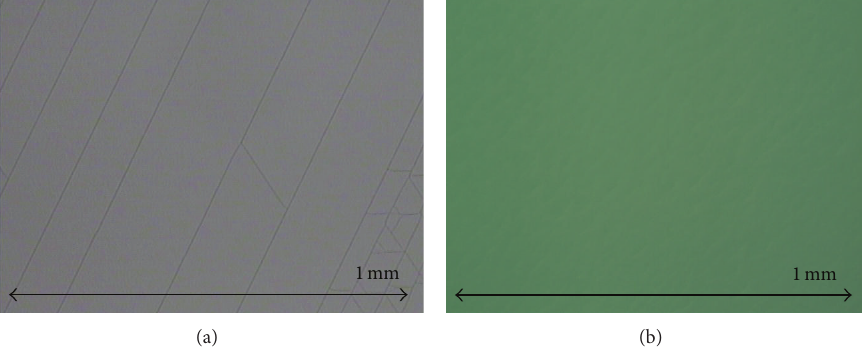
Figure 3: Optical photography of AlGaN/GaN surface grown on Si substrate with Al (a) and AlSiC precoverage interlayer (b). explains that AlSiC precoverage is effective in compensating tensile, considering the reference value of 567.5 cm −1 for the tensile stress in the GaN layer grown on Si substrate. The the freestanding GaN. It is believed that the insertion of Raman scattering spectra shown in Figure 4(a) exhibit peak AlSiC precoverage layer gives rise to strong compressive stress in the GaN film grown on Si substrate during the high shift at frequencies of 567.08 and 568.53 cm −1 for the grown temperature growth, which sufficiently overcomes the tensile film with Al and AlSiC precoverage, corresponding to the cal- stress caused by cooling down and remains compressive even culated biaxial stresses of 0.099 and − 0.240 GPa, respectively after completing the growth. Photoluminescence mapping [17]. This indicates that the biaxial stress in the AlGaN/GaN in inset of Figure 4(a) showed the average peek wavelength heterostructure grown on Si substrate with AlSiC precoverage at 361.5 nm, which belongs to the shifted wavelength is compressive while that with Al precoverage still remains